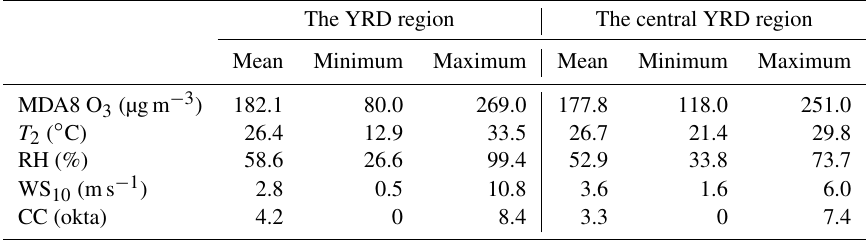
Table 3. Mean, minimum and maximum of MDA8 O 3 , T 2 , RH, WS 10 and CC during the daytime from 25 May to 3 June 2017. The YRD region The central YRD region Mean Minimum Maximum